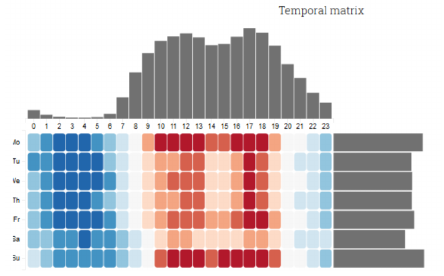
Figure 10. Temporal Matrix for Lucca municipality.